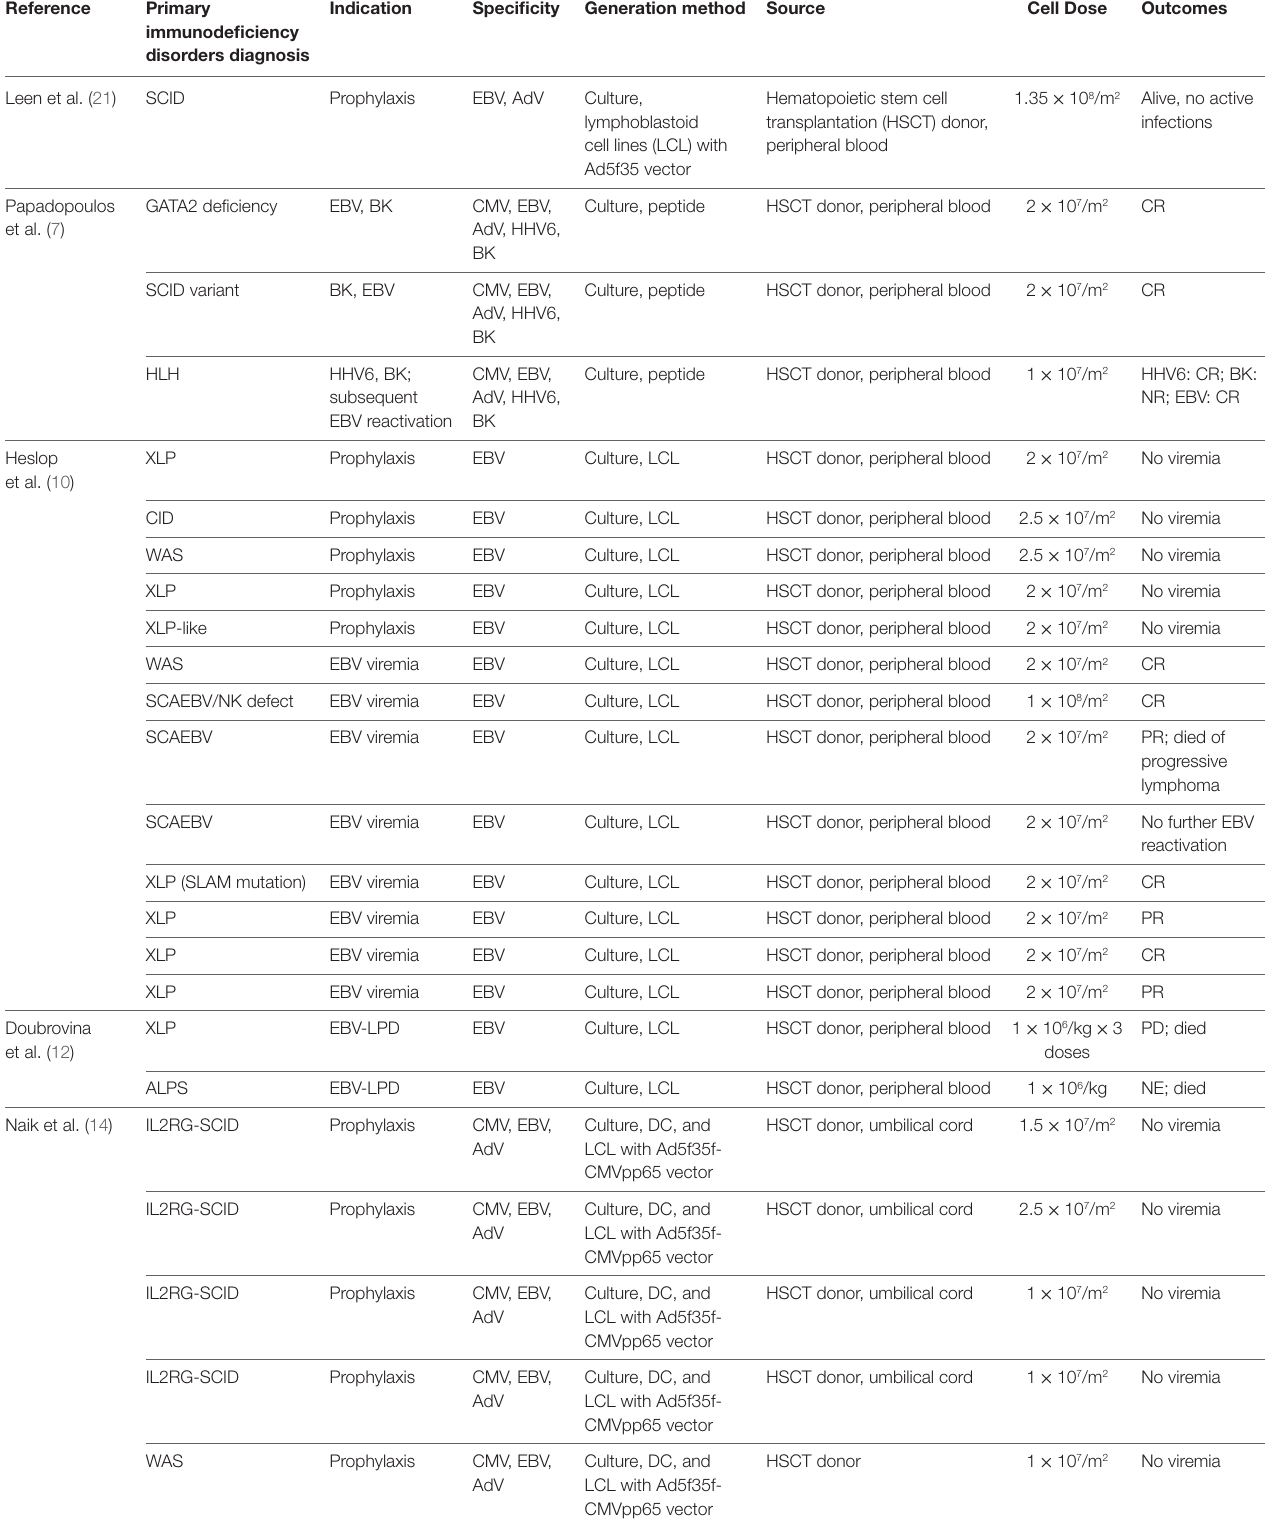
TABLe 1 | Previous clinical use of donor-derived EBV-specific T cells.